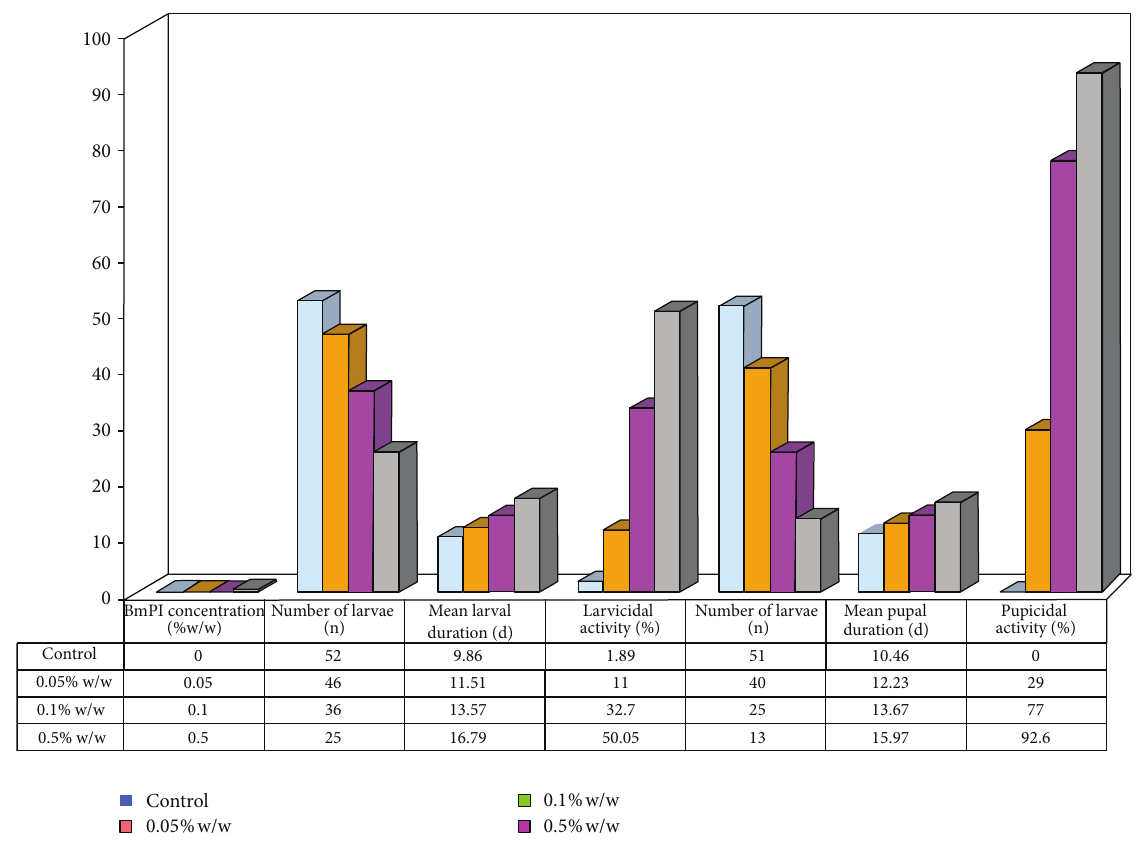
Figure 4: Effect of BmPI on H. armigera larval and pupal development. Number of larvae taken for study at each concentration ( 𝑛 = 52 ). d: days, n: number of